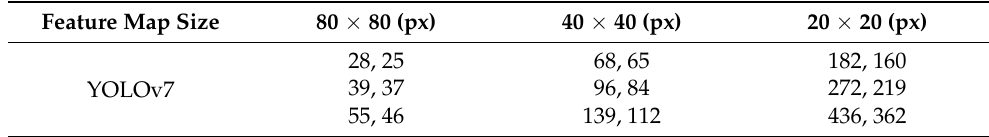
Table 2. Anchor box parameters of the URPC dataset.